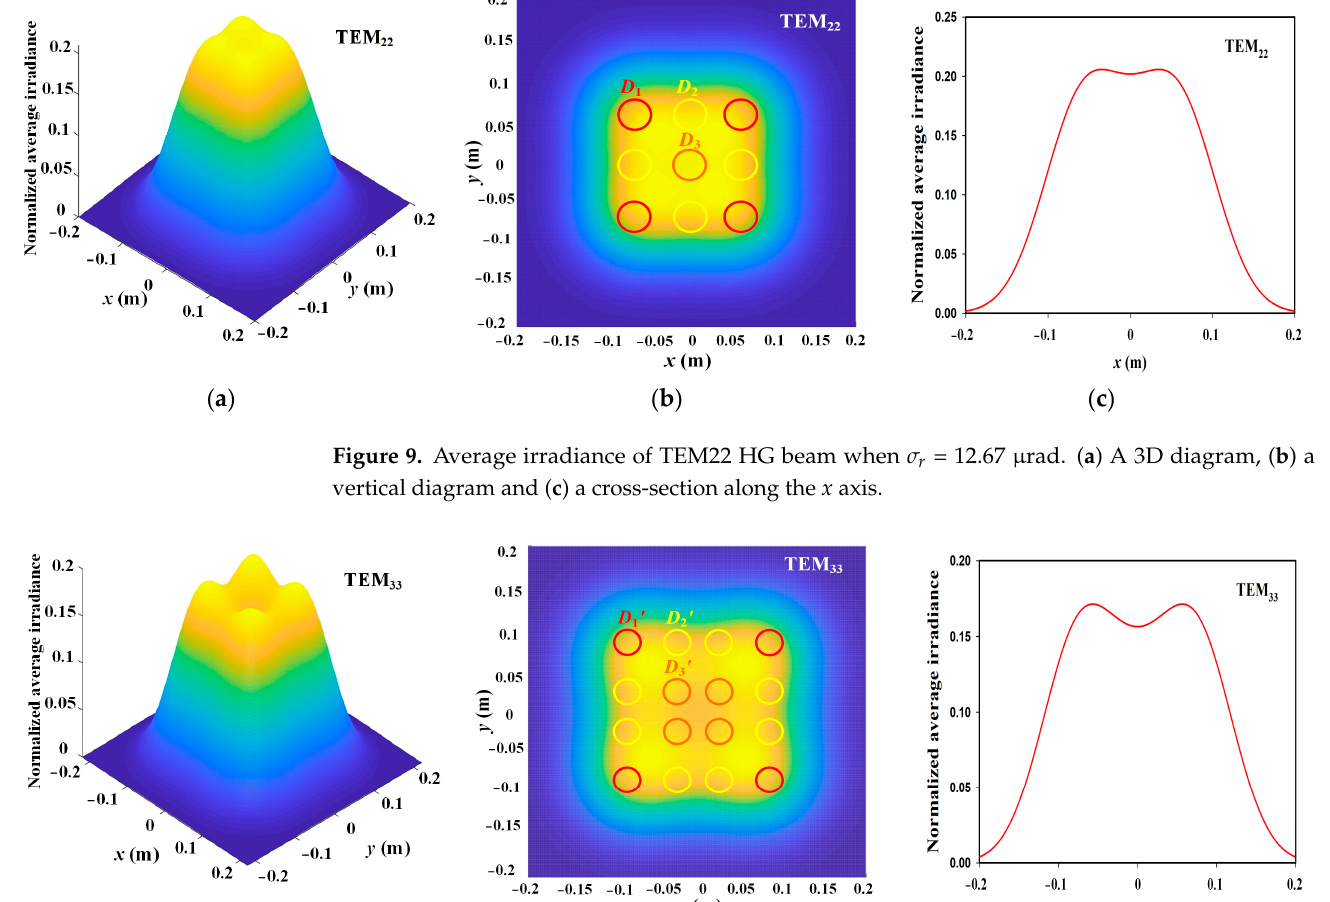
Figure 10. Average irradiance of TEM 33 HG beam when σ r = 14.05 µ rad. ( a ) A 3D diagram, ( b ) a vertical diagram and ( c ) a cross-section along the x axis.